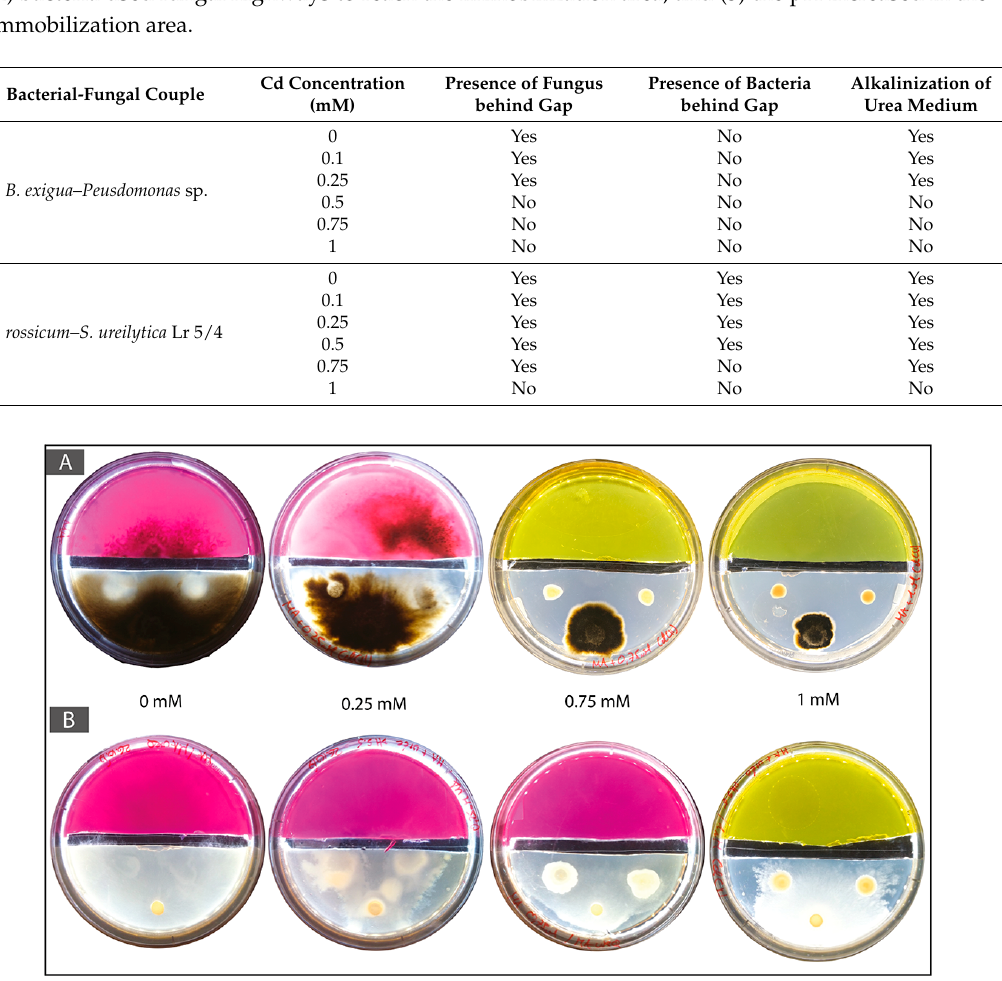
Figure 5. Experimental setting consisting of two-compartment systems in Petri dishes with a mobilization area (bottom part containing MA and Cd; 0 mM control and 0.5, 0.75, and 1 mM Cd) and an immobilization area (top colored part containing MA, 40 mM urea, and phenol red as pH indicator). Co-cultures of ( A ) B. exigua and Pseudomonas sp. ( B ) T. rossicum and S. ureilytica Lr 5/4. Table 3. Results of the Cd mobilization and immobilization experiment in two-compartments systems with the two synergistic couples ( B. exigua + Pseudomonas sp. and T. rossicum and S. ureilytica Lr 5/4) showing at each Cd concentration assessed whether (1) the fungus reached the immobilization area, (2) bacteria used fungal highways to reach the immobilization area, and (3) the pH increased in the immobilization area.